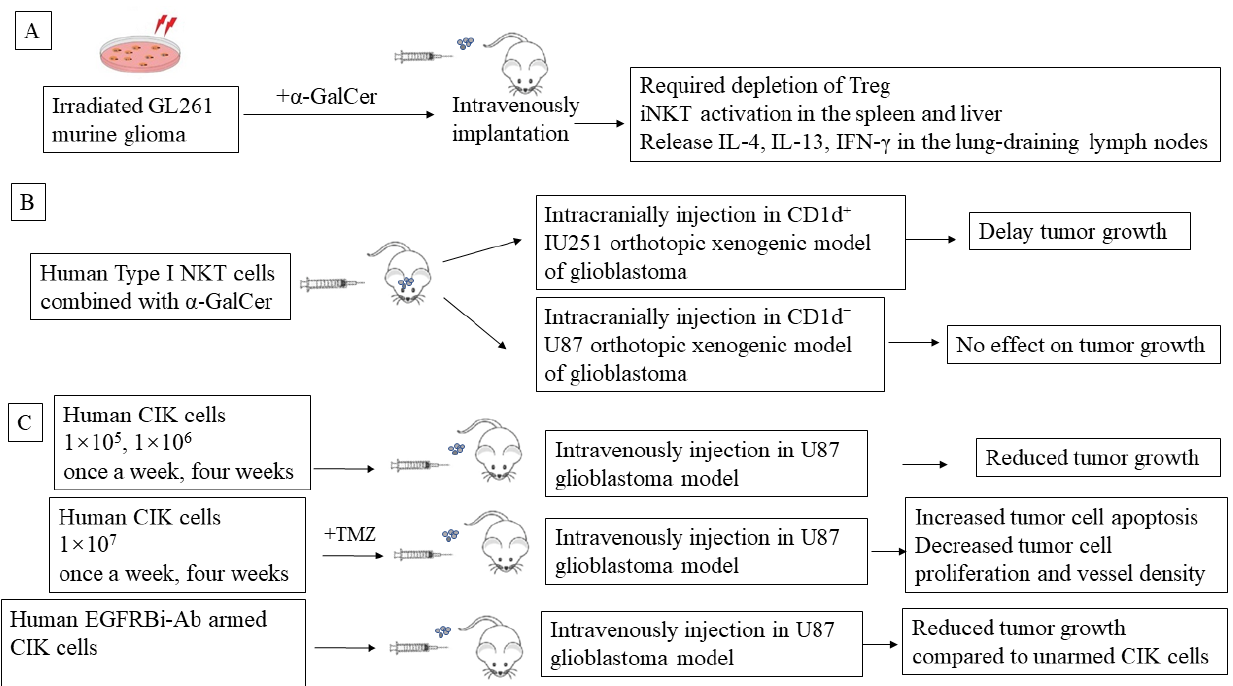
Figure 2. NKT immunotherapy in murine glioblastoma models. ( A ) An irradiated GL261 murine glioma loaded with α‐ GalCer was implanted intravenously to activate iNKT cells. ( B ) In a CD1d ‐ positive U251, orthotopic xenogenic model of glioblastoma, intracranially co ‐ injected human type I NKT cells with α‐ GalCer. ( C ) hCIK cells/hEGFRBi ‐ Ab armed CIK were injected into the tail veins of immune ‐ compromised mice bearing U ‐ 87MG tumors in their brains. (adapted from references [99,106,107]).